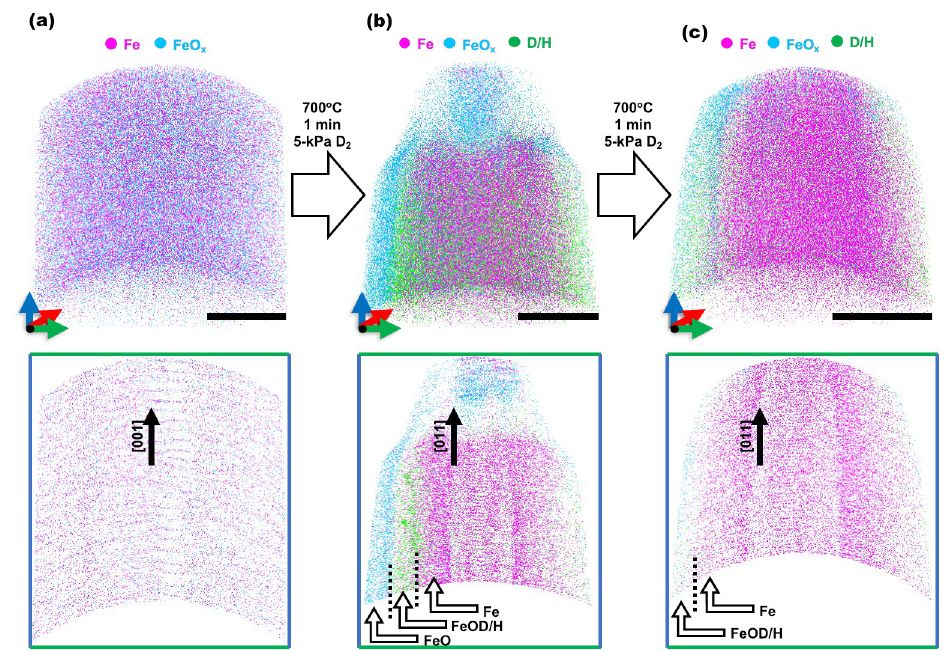
Fig 9. Atom probe characterization of pristine single crystal wu¨stite and its reduced states. Atom maps of FeO, Fe and D/H showing the progress of the deuterium-based reduction and the orientation relationship established by during the reduction (All scale bars are 20 nm).